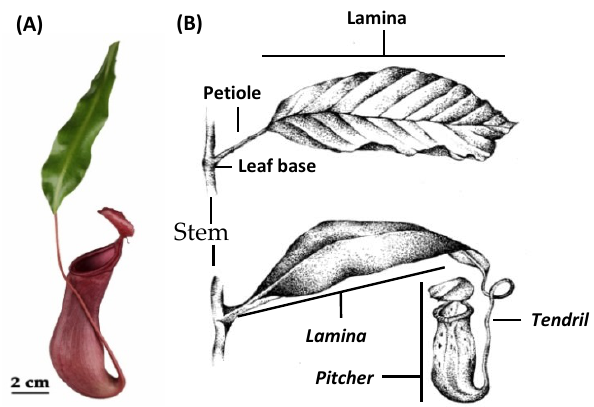
Figure 2. Comparison of leaf morphology. ( A ) Nepenthes x ventrata leaf. ( B ) Typical foliage leaves (upper), Nepenthes leaf (below). In italics, the leaf parts developed in Nepenthes as result of metamorphosis of the typical leaf parts. For further explanation, see the text. Copyright © of drawing ( B ) held by Sarah Zunk.